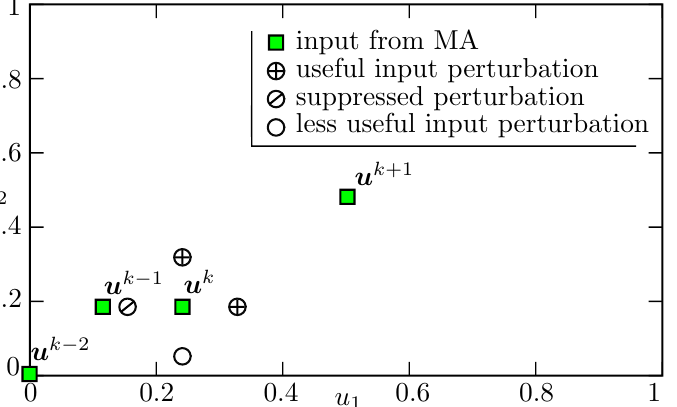
Figure 3. Illustration of active perturbation strategy with input perturbations around current